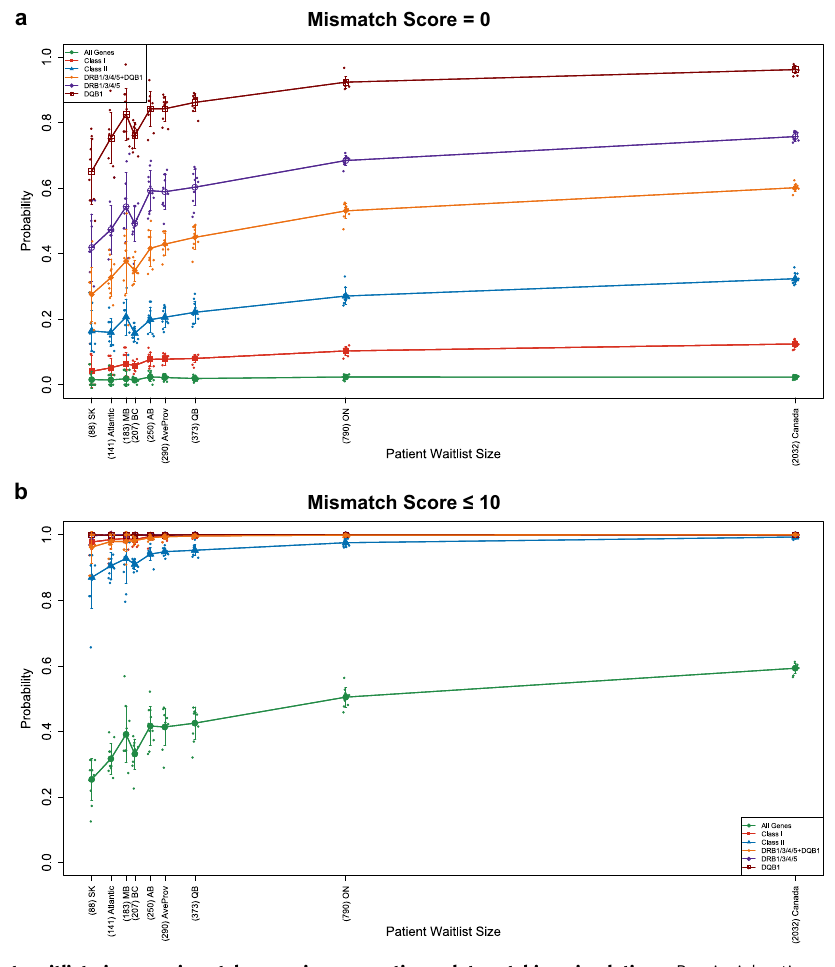
Fig. 9 The effect of patient waitlist size on mismatch score in prospective eplet matching simulations. Provincial active waitlist and deceased donor numbers were used according to Canadian Organ Replacement Register 3 . X axis shows the number of patients on provincial or national waiting lists (SK Saskatchewan with 88 patients, Atlantic Atlantic provinces (New Brunswick, Nova Scotia, and Prince Edward Island) with 141 patients, MB Manitoba with 183 patients, BC British Columbia with 207 patients, AB Alberta with 250 patients, AveProv Average across all provinces with 290 patients, QC Quebec with 373 patients, ON Ontario with 790 patients, and Canada with 2,032 patients). Y axis shows the averaged cumulative probability of achieving a total eplet mismatch score of 0 ( a ) or 10 or lower ( b ). Jittered dots represent the cumulative probabilities at each individual simulation. Error bars are calculated as the standard deviation of ten repeated independent simulation